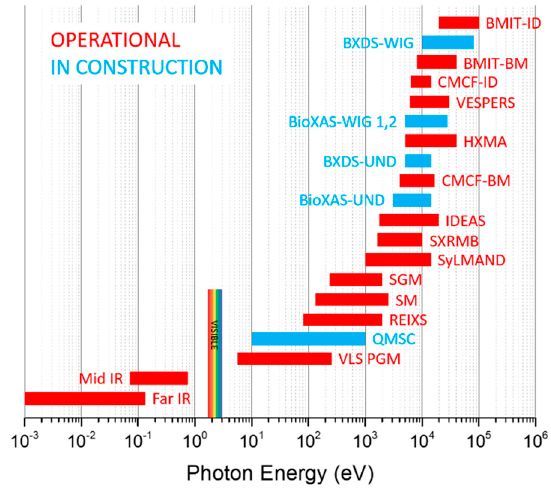
Figure 2. Available photon energy ranges for the operational and under construction experimental facilities. IR: Infrared.